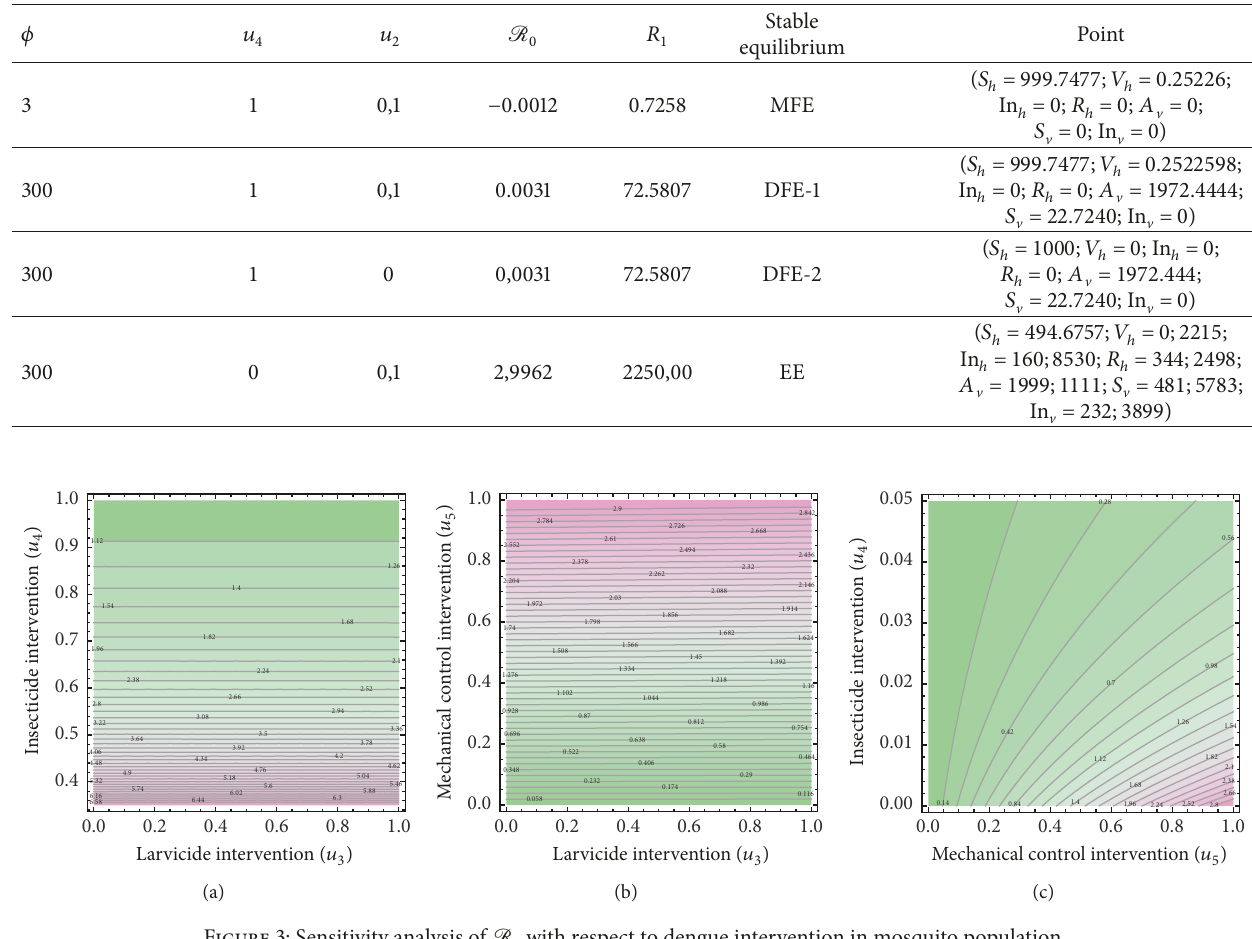
Figure 3: Sensitivity analysis of R 0 with respect to dengue intervention in mosquito